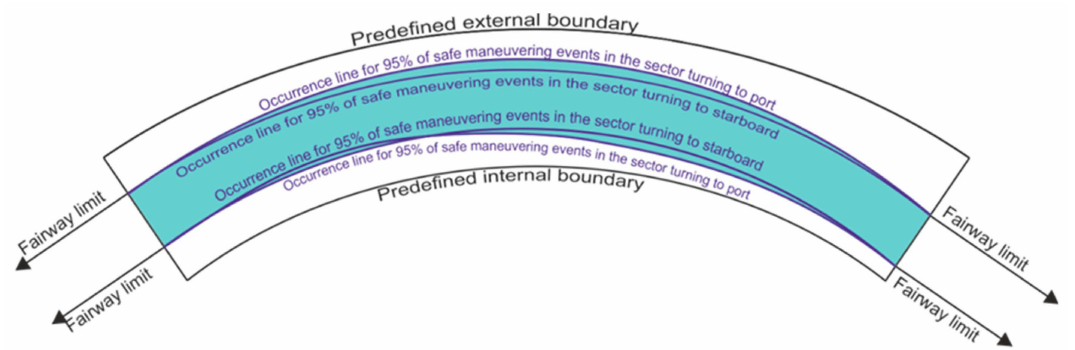
Figure 5. An example outcome of tests conducted by the kinematic method of numerical simulation. Recommended shape of the bend is presented in